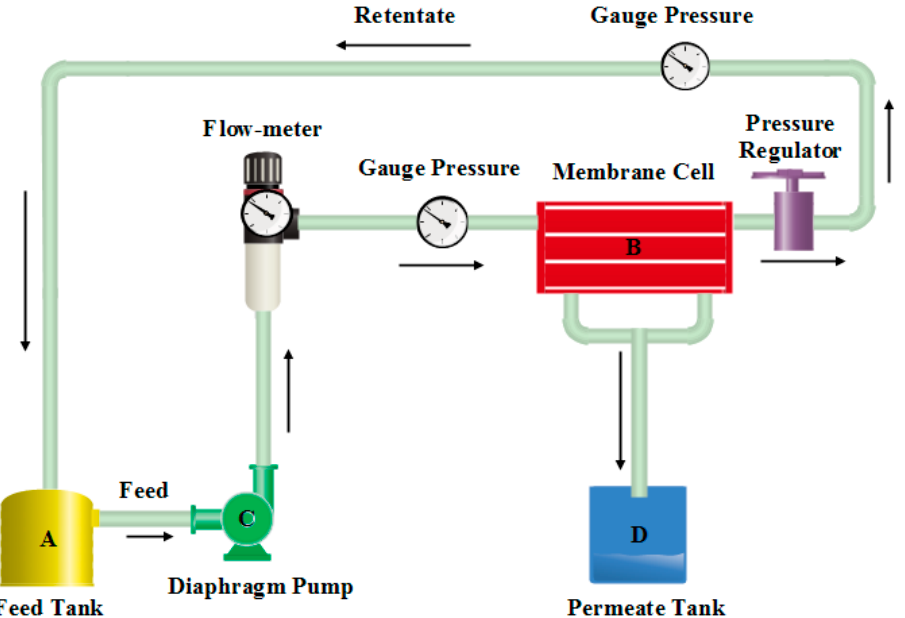
Figure 3. Schematic diagram of the experimental nanofiltration